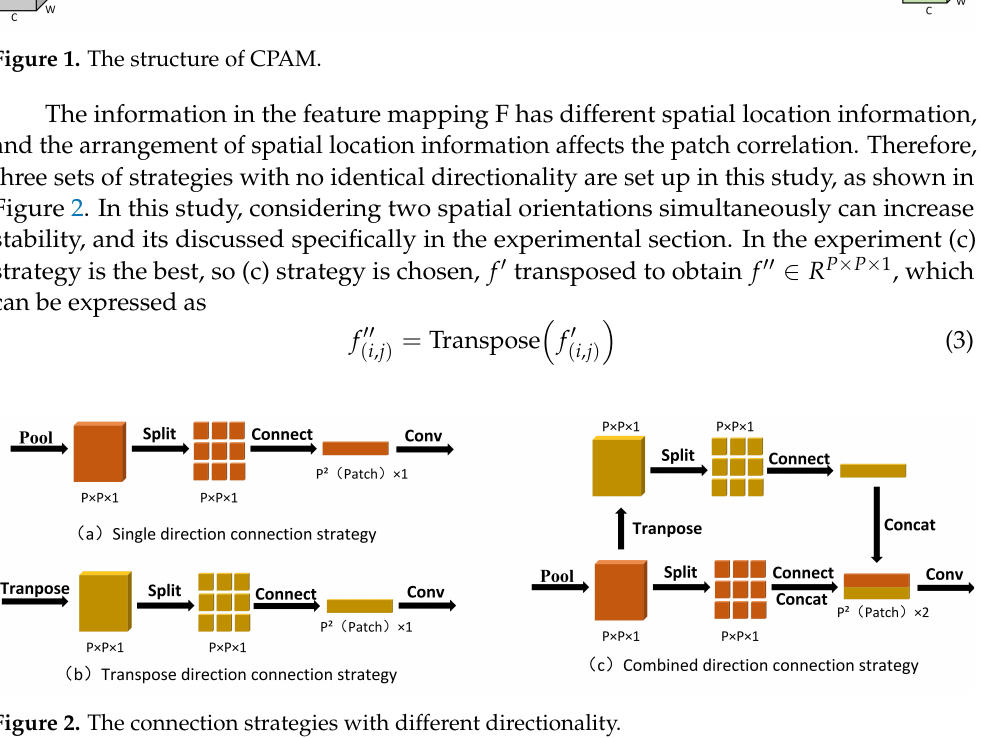
Figure 2. The connection strategies with different